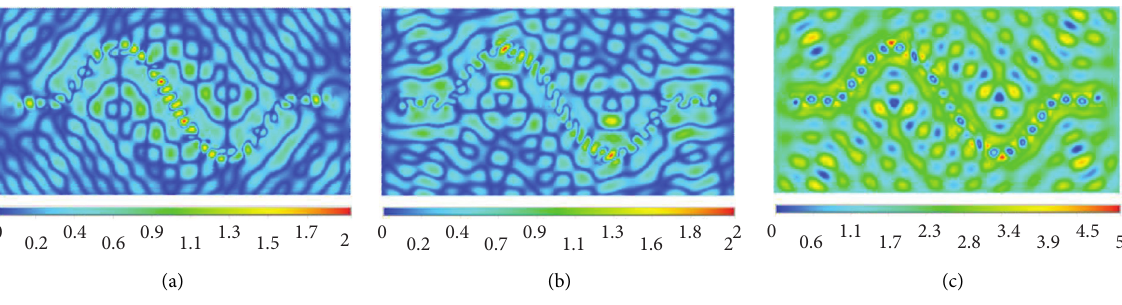
u u x , (b) y , and (c) z